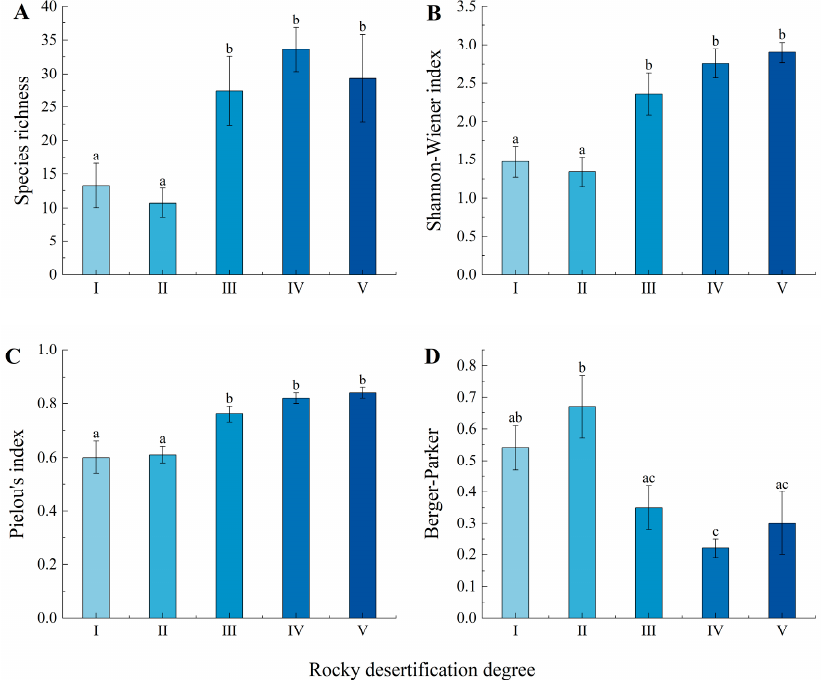
Figure 1. The species diversity indices of plant communities in plots with di ff erent rocky deserti fi - cation degrees in northern Guangdong. Note: ( A ) species richness; ( B ) Shannon–Wiener index; ( C ) Pielou’s index; ( D ) Berger–Parker index. Sites without the same le tt er are signi fi cantly di ff erent. Table 2. The species and importance values of woody plants in areas with di ff erent rocky deserti fi - cation degrees.